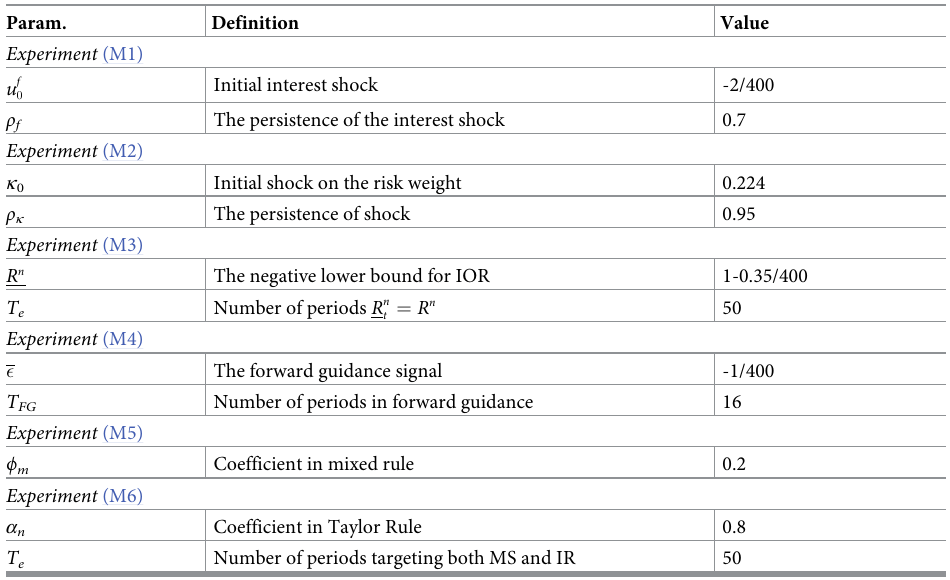
Table 8. Parmeter values in experiments.